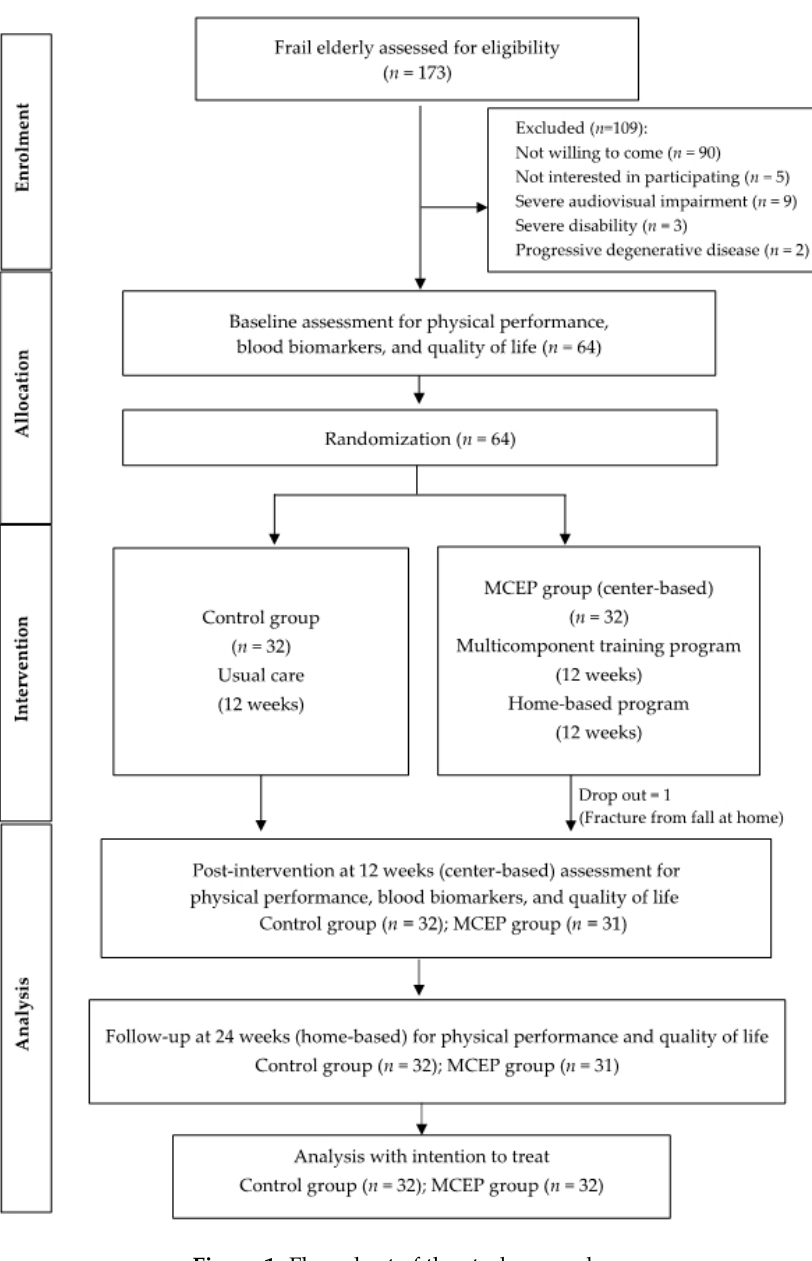
Figure 1. Flow chart of the study procedure.